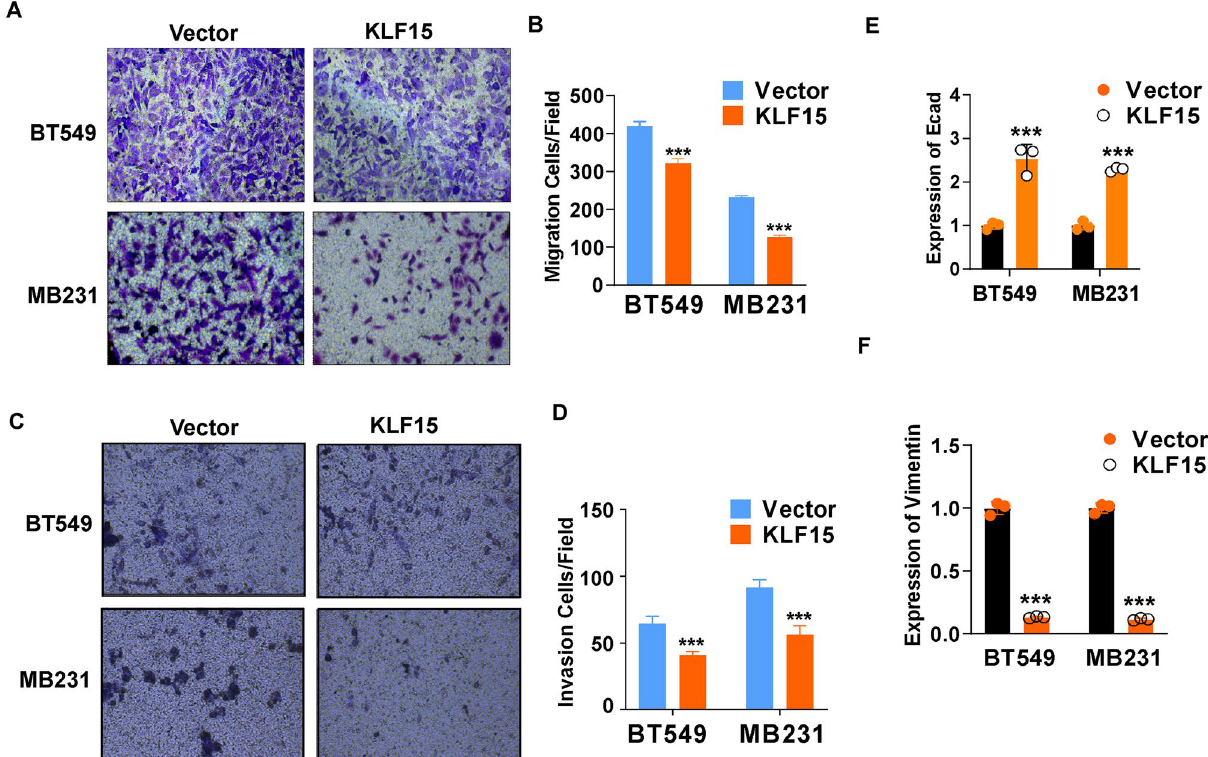
Figure 5. Overexpressed KLF15 suppressed breast cancer cell migration and invasion ability. ( A , B ) Representative images and quantification of Transwell migration assay conducted with stably transfected MDA-MB231 and BT549 cells, magnification times: × 200. ( C , D ) Representative images and quantification of Transwell invasion assay conducted with stably transfected MDA-MB231 and BT549 cells, magnification times: × 200. Three independent experiments were performed respectively. ( E , F ) After MDA-MB231 and BT549 cells were overexpressed with KLF15, mRNA expression of E-cadherin and Vimentin were examined. *** p <